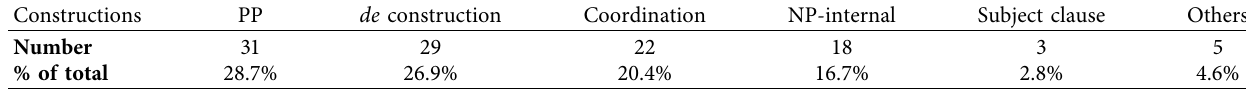
Table 6: Constructions containing verb parsing errors.